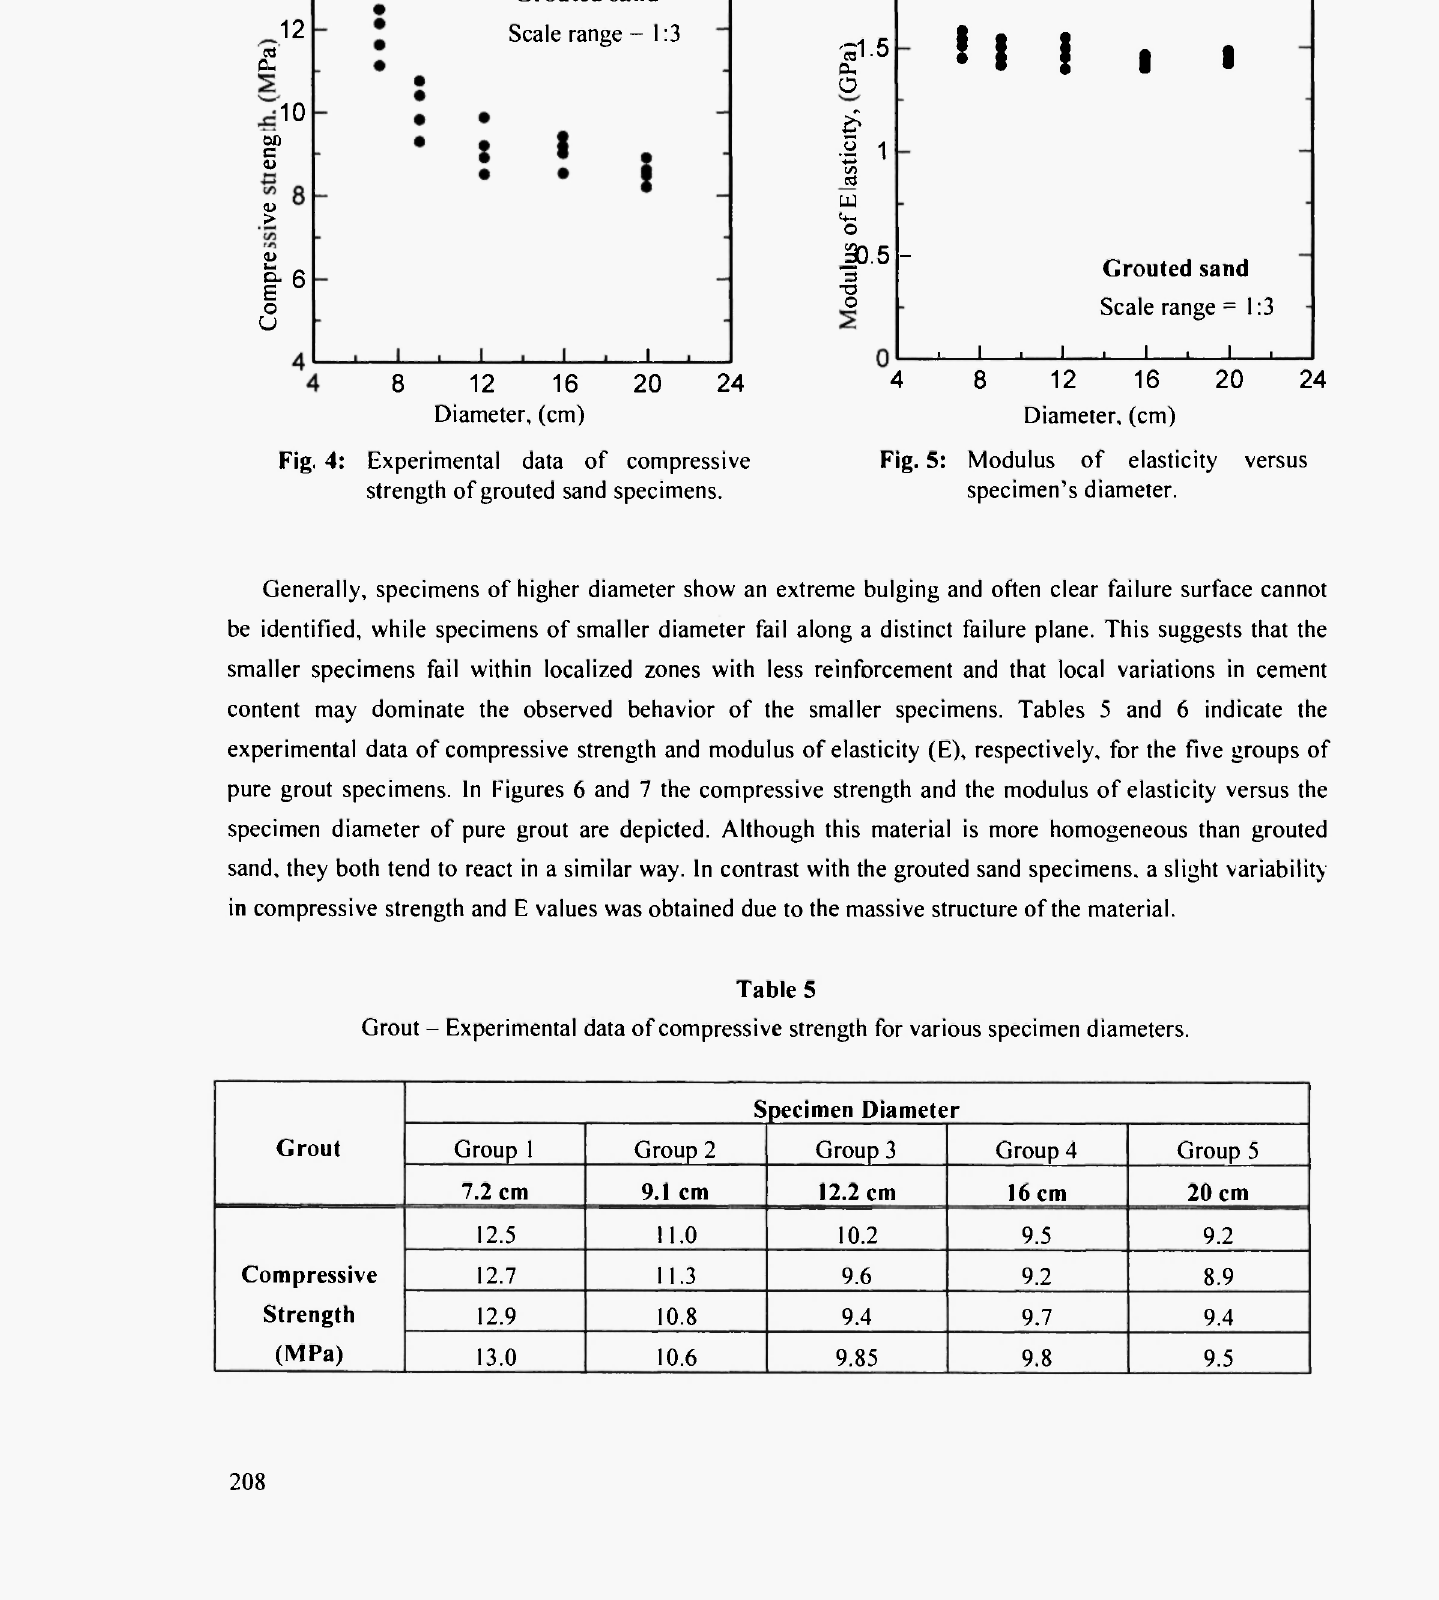
Grout - Experimental data of compressive strength for various specimen